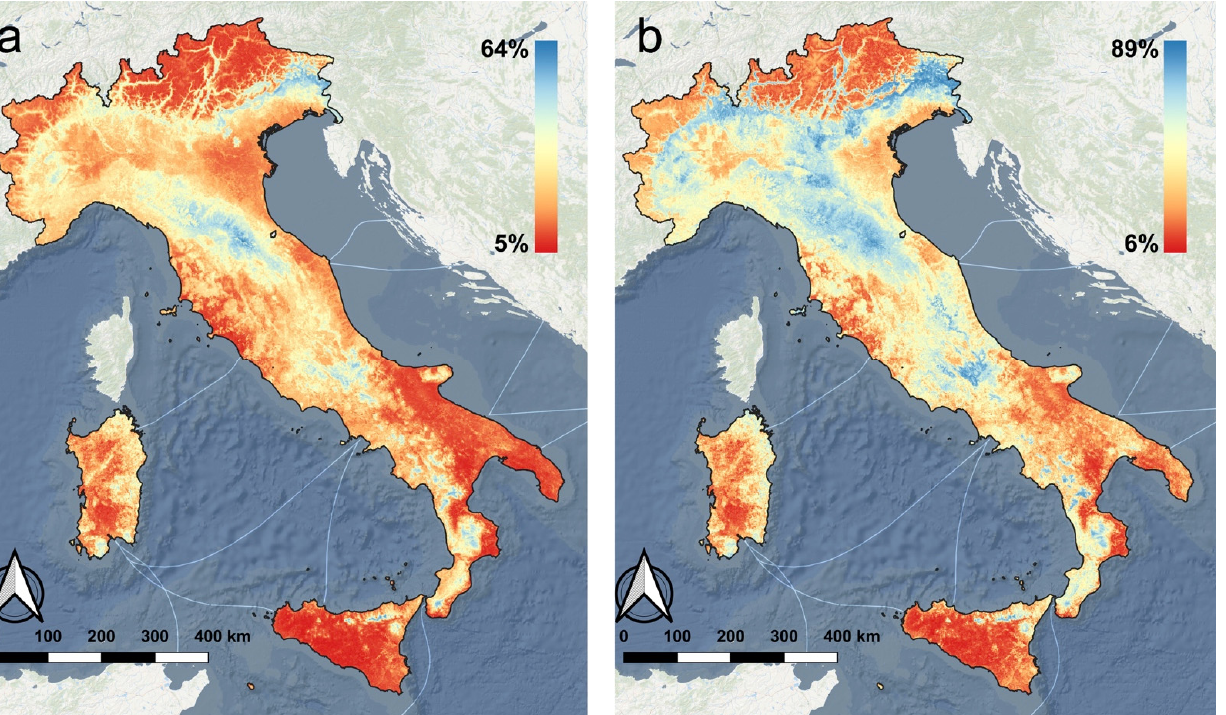
Figure 3. Maps of the suitable habitat for the big five , where the colour scale represents the habitat suitability (HS) from minimum (red) to optimal HS (green). In ( a ), the HS mean map indicates the hot spots for the big five conservation as a whole, derived from the raster layer produced by averaging the HS of each TU. In ( b ), the HS max map, produced by selecting the maximum value of each cell among the TUs’ HS maps, shows those relevant areas for the conservation of at least one TU (green) and meaningless areas for big five conservation (red). For the HS maps of each TU and the raster layers of HS mean and HS max please refer to the supplementary material (HS_maps_raster_layers.zip). Table 2. Summary of the SDM framework results, reporting the actual number of occurrence data, the generated pseudo-absence for each taxonomic unit (TU), together with the means of each cal- culated metric per modelling method. Metrics’ means were calculated from the model outcomes (n° 24) for each TU (reported in supplementary material Table A1).